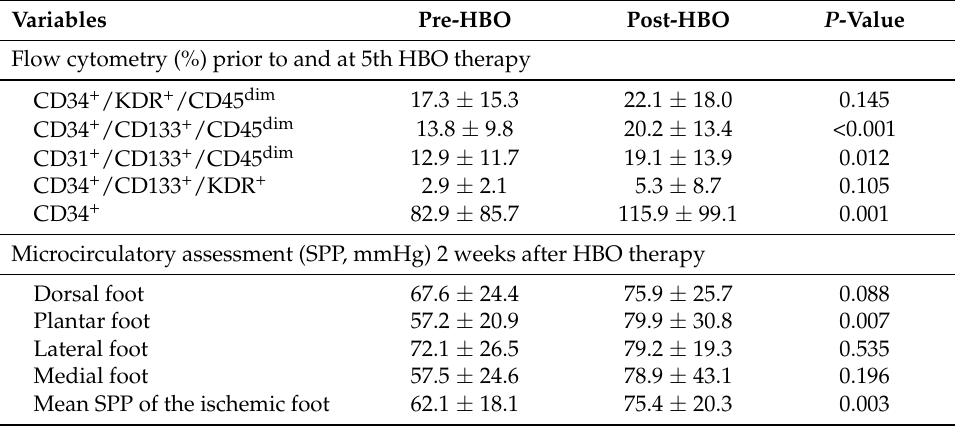
Table 2. Change in circulatory EPCs and SPP of the ischemic foot before and after HBO therapy. Variables